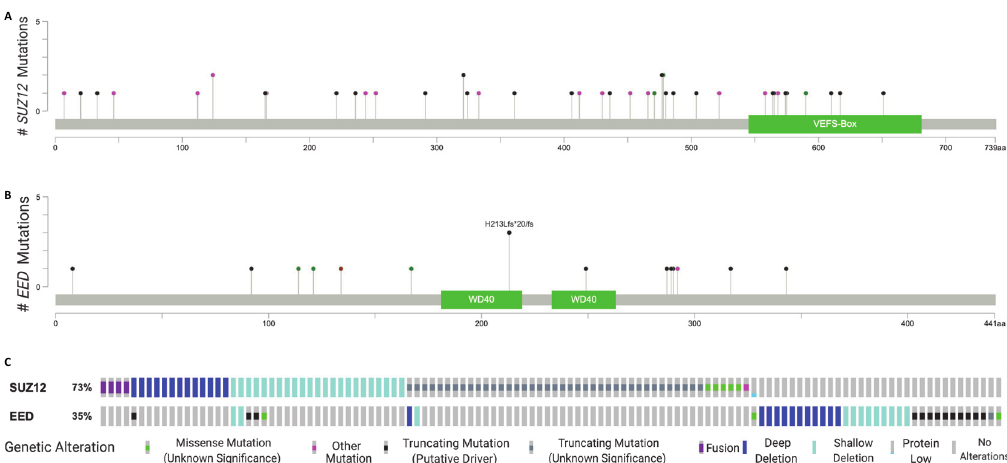
Figure 2. A compiled overview of SUZ12 and EED alterations identified in malignant peripheral nerve sheath tumors (MPNST) published to date, accounting for approximately 75% of sequenced cases. ( A ) A representation of single nucleotide variants (SNVs) discovered in SUZ12 thus far in MPNST sequencing studies. ( B ) EED SNVs identified through sequencing studies. ( C ) An Oncoprint map of the various mutations discovered in both SUZ12 and EED across the MPNST samples sequenced thus far. Figure generated using OncoPrinter and MutationMapper from https: // www.cbioportal.org /